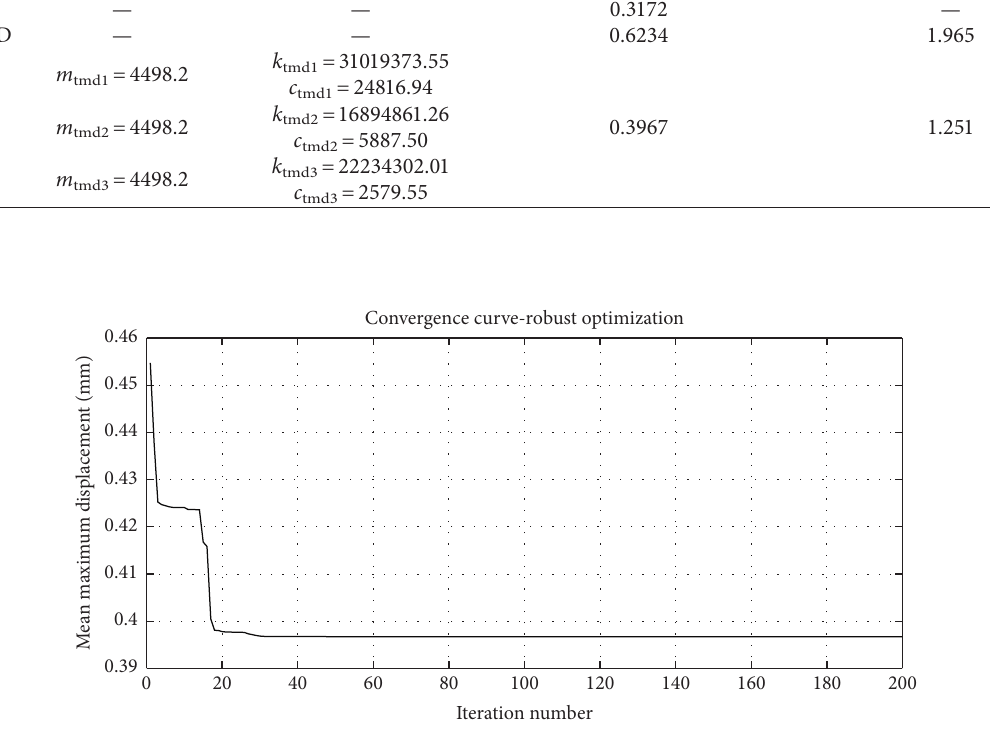
Figure 14: Convergence curve for the robust